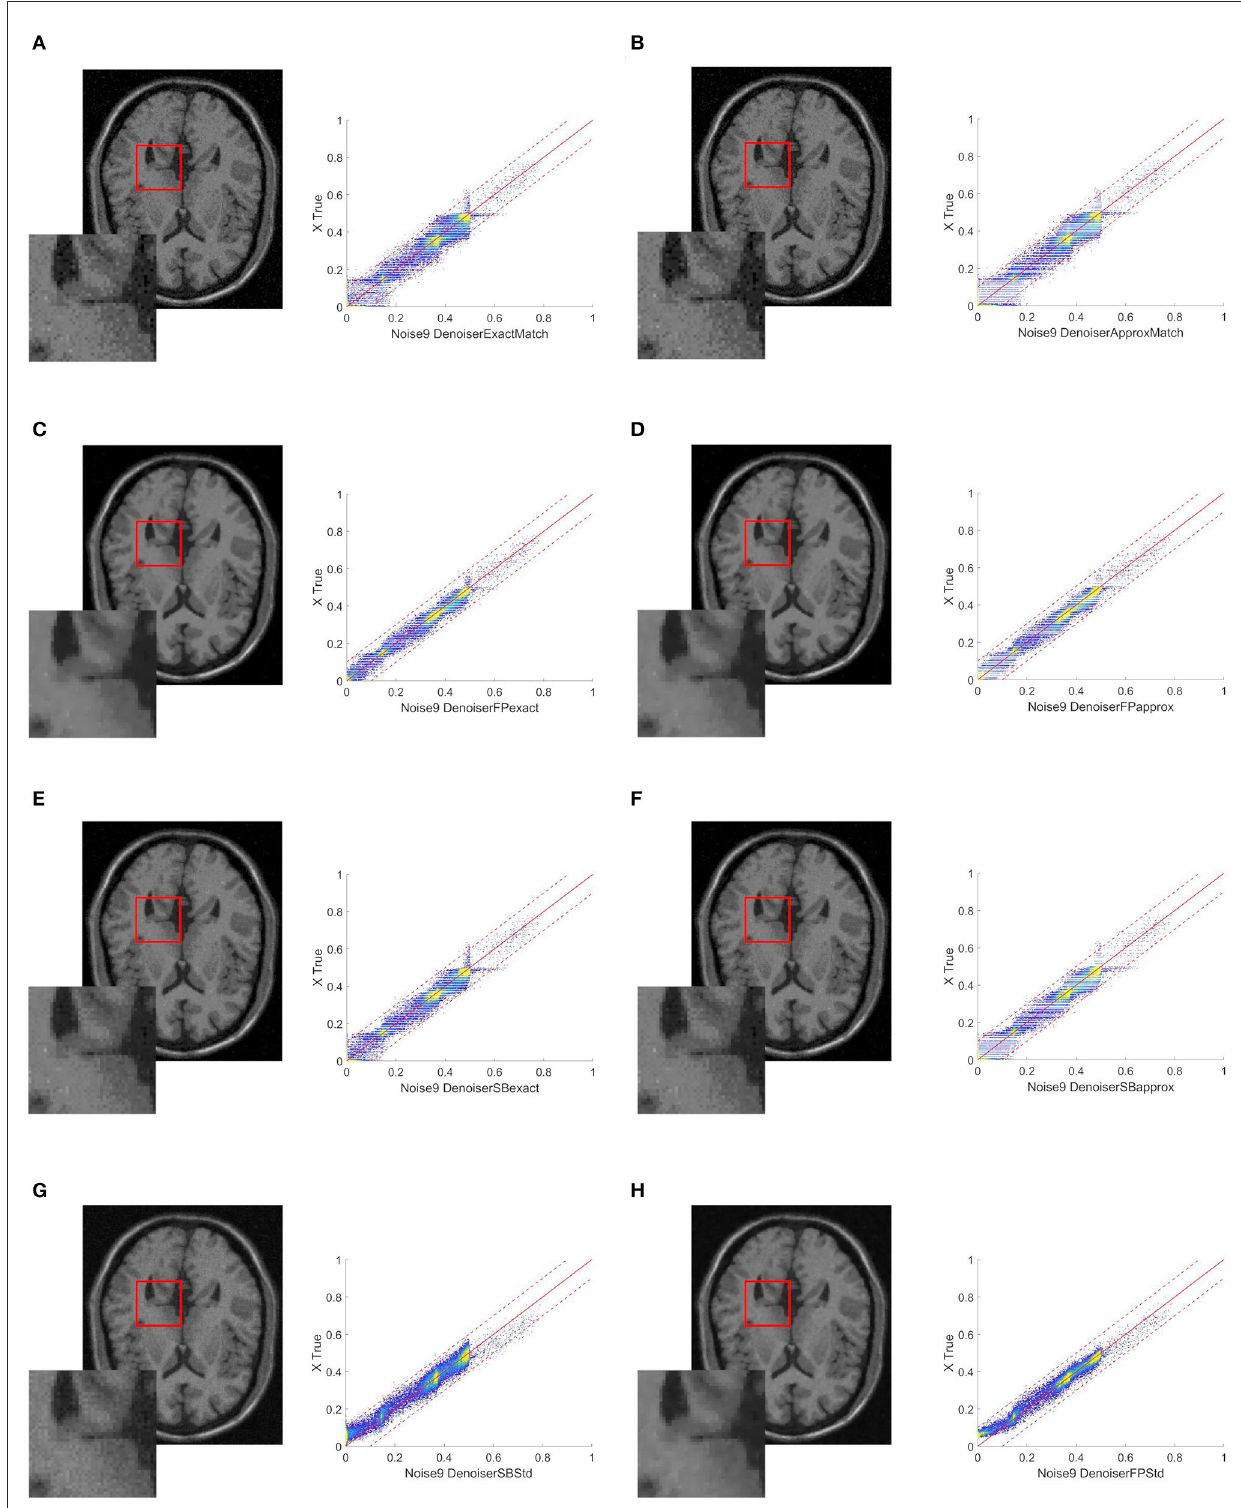
FIGURE2 Resulting images when the target image is collected at a distance of -5 mm from the original image (A) ExactMatch and (B) ApproxMatch applied to the image with 9 % noise. (C) FP exact and (D) FP approx denoiser applied to the image with 9 % noise. (E) SB exact and (F) SB approx applied to the image with 9 % noise. (G) SB standard and (H) FP standard applied to the image with 9 %